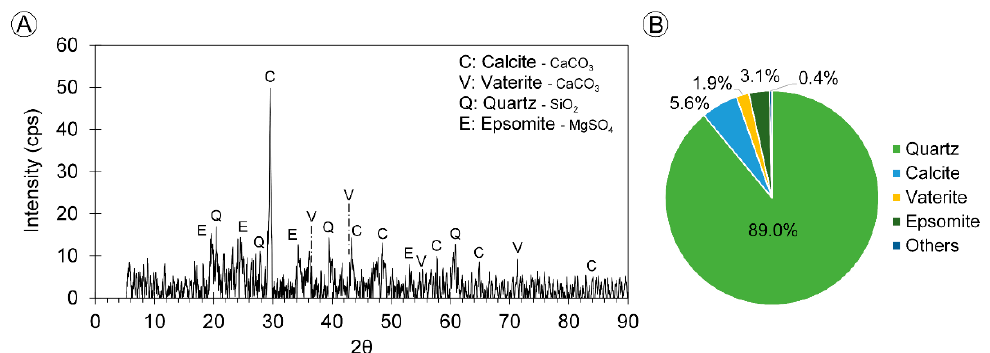
Figure 7. Intensity distribution of the stalactite minerals by the powder X-ray diffraction analysis. ( A ) diffraction pattern; ( B ) relative mineral abundance of the detected minerals.